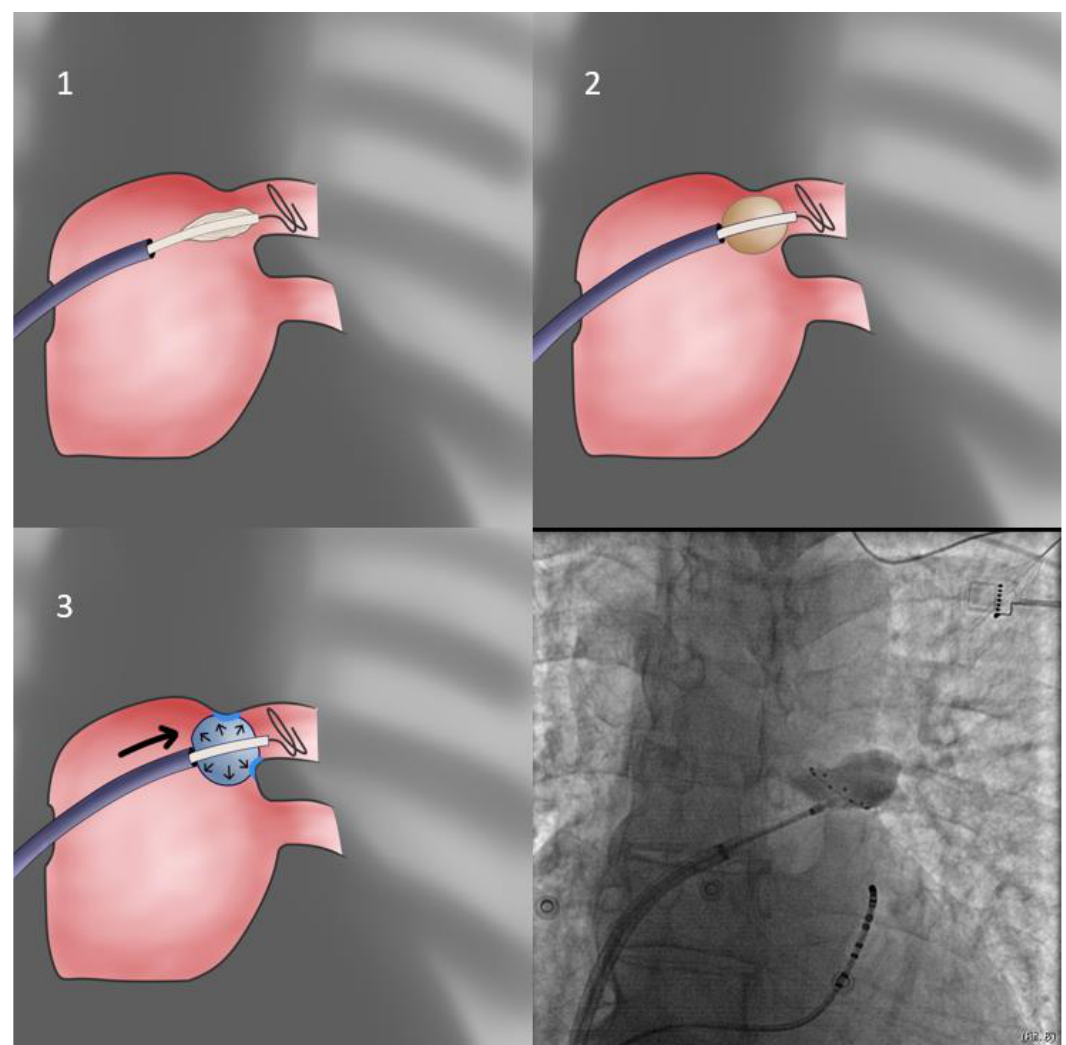
Figure 4. Delayed occlusion approach. This variation of the direct approach takes advantage of the slight increase in diameter of the balloon once it freezes. Thus, the operator will apply pressure when the temperature has started dropping below 20 °C, attempting to achieve better sealing. Otherwise, it is identical to the direct